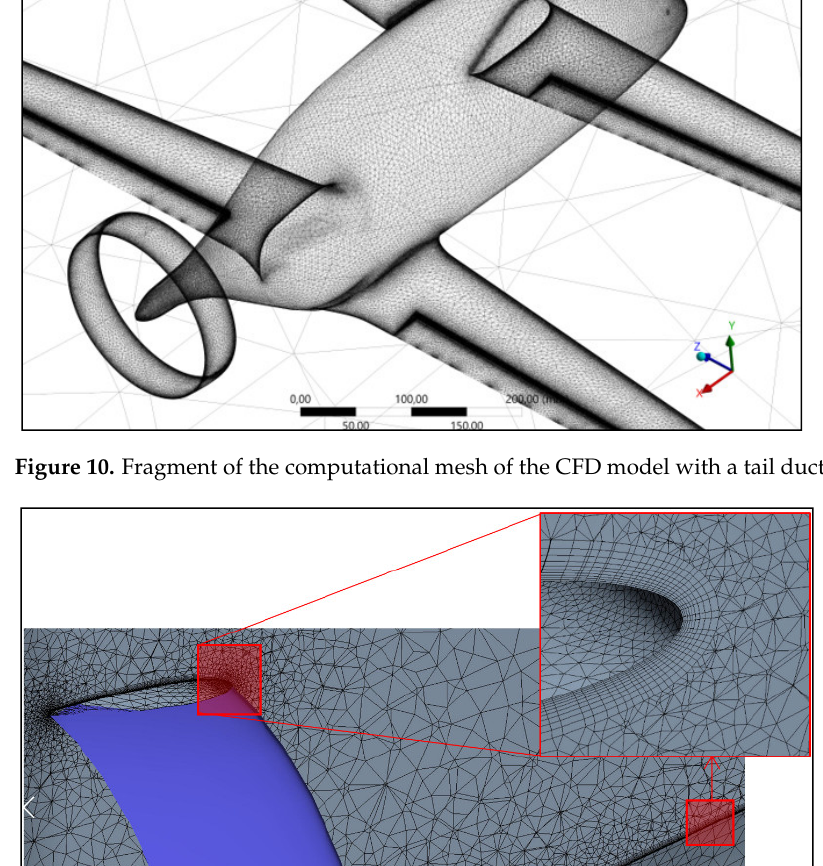
Figure 12. Distribution of wall Y+ values on the CFD model with a duct. 2.2.2. Governing Equations, Discretization Schemes, and Turbulence Modelling Below are the governing equations solved by the RANS model for an incompressible, low subsonic flow: Continuity equation: